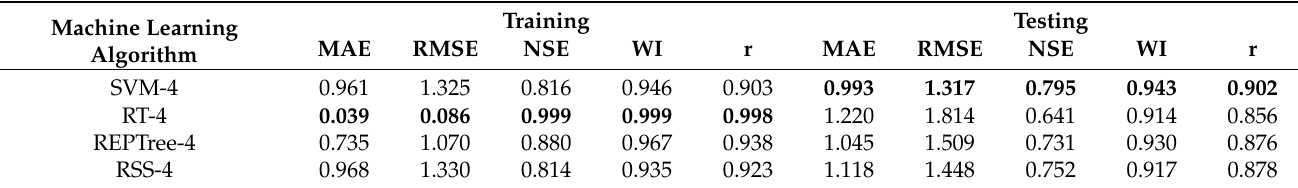
Table 8. RMSE, NSE, WI, and r for meta-heuristic algorithms-based models during the training and testing phase at the Ludhiana